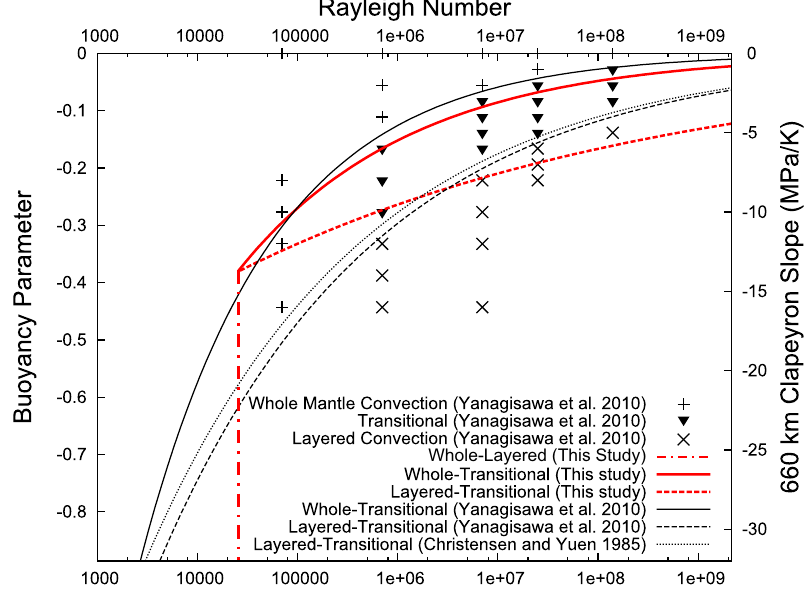
Fig. 4. Data points and curves from the study of Yanagisawa et al. (2010) with the curve from Christensen and Yuen (1985) overlaid on the domain boundary lines of this study. While we note a reasonable agreement between the points and the lines from this study, all the points do not satisfy our lines. This could be the result of the slightly different parameters and the measure of subjectivity in defining the behaviour category of a simulation. Key differences between our curves and those from previous work are the wider transitional region at high Ra and the meeting point of our curves.